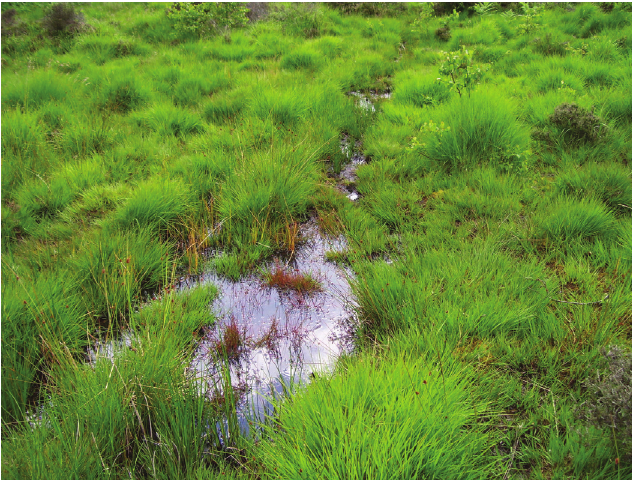
Fig. 4. Cattle grazed wet grassland in Epping Forest, UK, habitat for Omocestus viridulus , credit T. Gardiner.